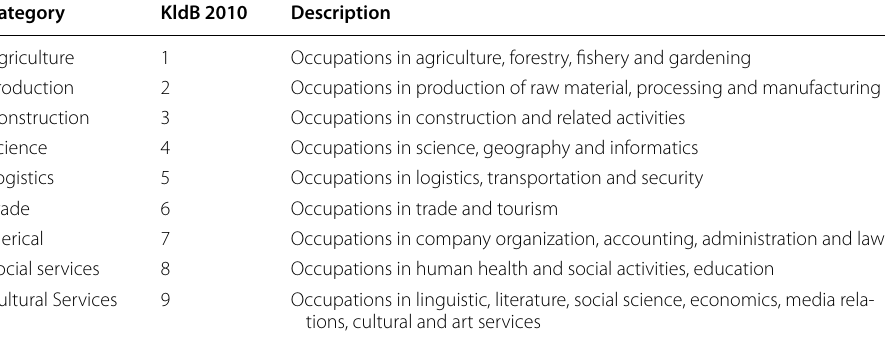
Data source: Bundesagentur für Arbeit